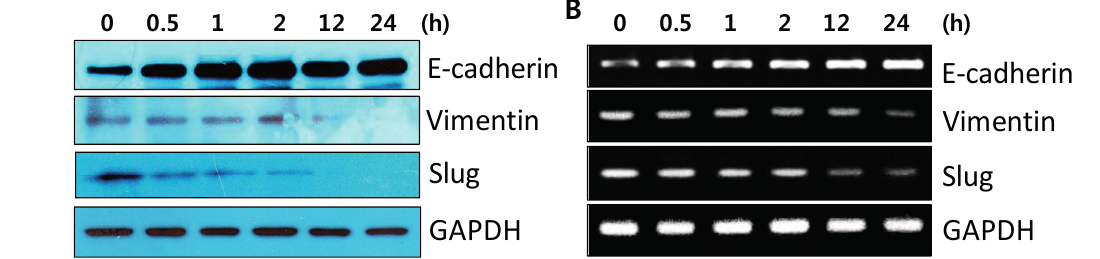
Figure 2. Time-dependent expression of EMT-related genes in HaCaT cells after treatment with DK223. ( A ) Protein expression was examined in HaCaT cells treated with 2 μ M DK223 for different time periods using Western blot analysis with the specific antibodies indicated ( B ) mRNA expression was investigated by RT-PCR with the specific primers